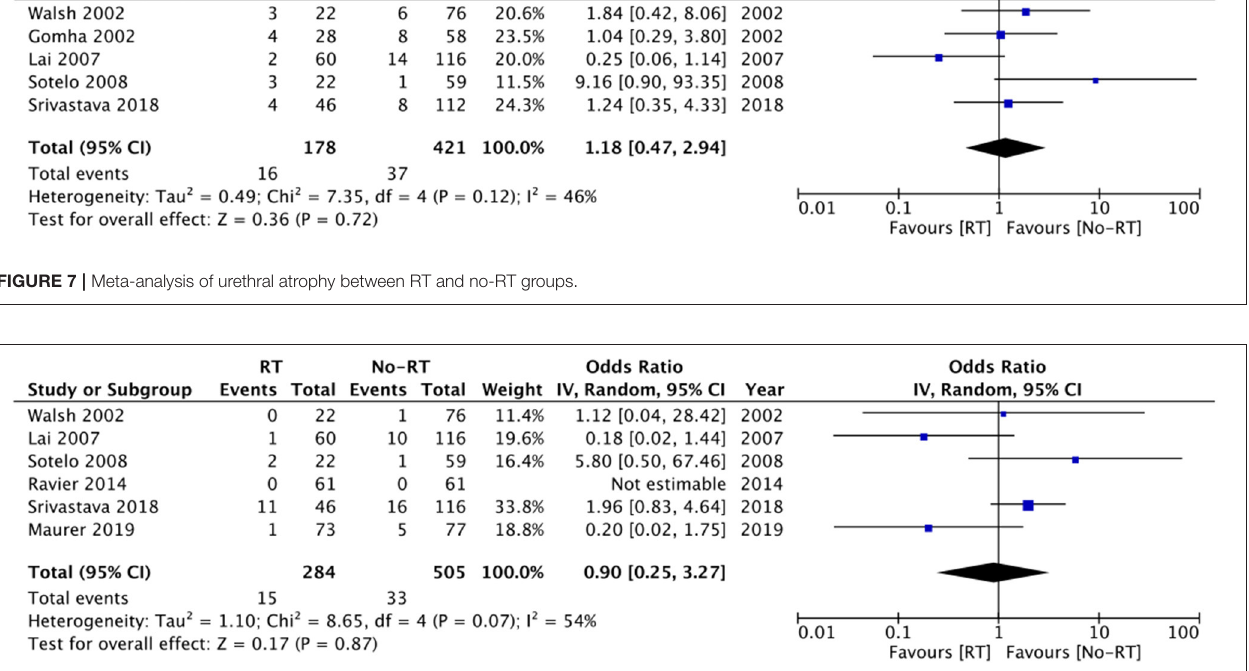
FIGURE 8 | Meta-analysis of mechanical failure between RT and no-RT